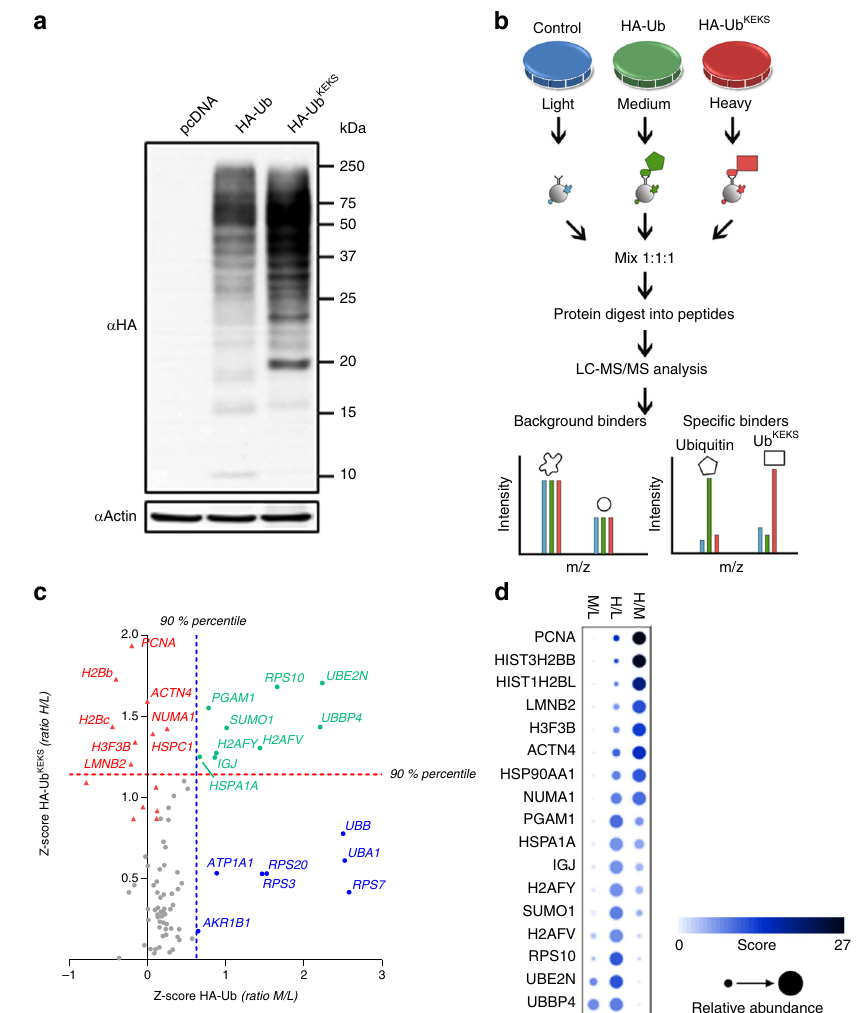
Fig. 3 Ub KEKS targets proteins with a different speci fi city compared with Ub. a HeLa cells were transfected with empty vector (pcDNA), HA-Ub or HA- Ub KEKS . Proteins were extracted and analyzed by western blot with antibodies against the HA tag or actin ( n = 3 independent experiments). b Proteins from SILAC-labeled cells either with light amino acids (control) or with heavier isotopes (M or L) for quanti fi cation of proteins enriched in HA-Ub IPs versus HA-Ub KEKS IPs. c Z -scores of H/L and M/L ratios for each protein detected in all conditions (heavy, medium, and light). Proteins signi fi cant (above the 90% percentile) for HA-Ub are indicated in blue, in red for HA-Ub KEKS , and in green for both. Signi fi cance lines are indicated as a blue dotted line (90% percentile for M/L z -scores) and as a red dotted line (90% percentile for H/L ratios). Proteins with a signi fi cantly high H/M ratio (speci fi c to Ub KEKS versus Ub) are indicated as red triangles. Axis are limited to area of interest, thus some values do not appear on this graph. These experiments were performed in biological triplicates ( n = 3). d Proteins identi fi ed in at least two replicates with a signi fi cant ratio of enrichment are represented using a dot plot. The color and size of the dots are proportional to their z -scores and relative abundance, respectively. Source data are provided as a Source Data fi